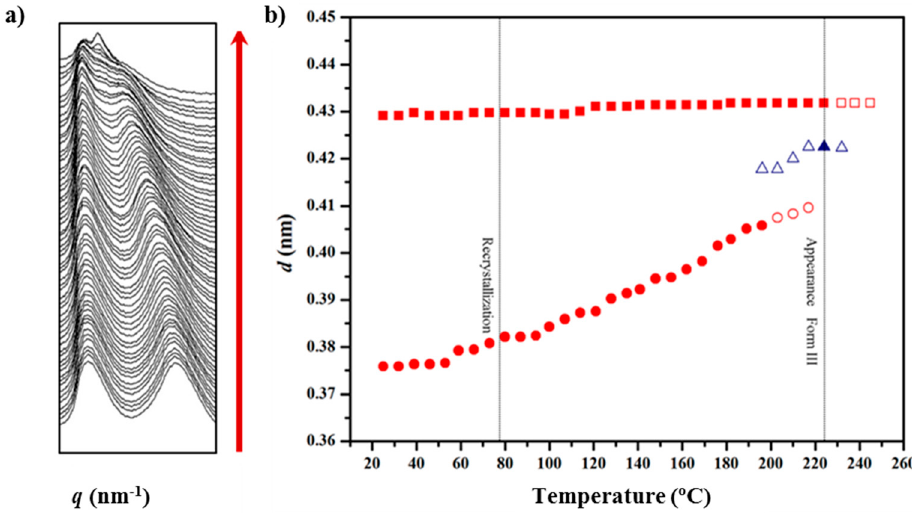
Figure 6. ( a ) Three-dimensional representation of WAXD profiles of a solution crystallized nylon 4 9 sample during heating (10 °C/min) from room temperature to fusion; and ( b ) evolution of the spacings of the two main reflections during the first heating. Full and empty symbols indicate well-defined and intuited reflections, respectively. The temperatures at which structural transitions occur are indicated with vertical lines. Reflections corresponding to Forms I and III are indicated in red and blue, respectively.